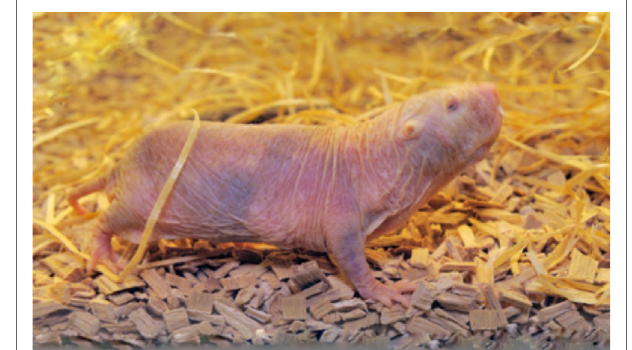
FiGURe 1 | Structural formula of a disaccharide building block of the hyaluronan polymer composed of alternating d -glucuronic acid and N -acetyl- d -glucosamine units. n indicates the number of repeating units in a polymer molecule.